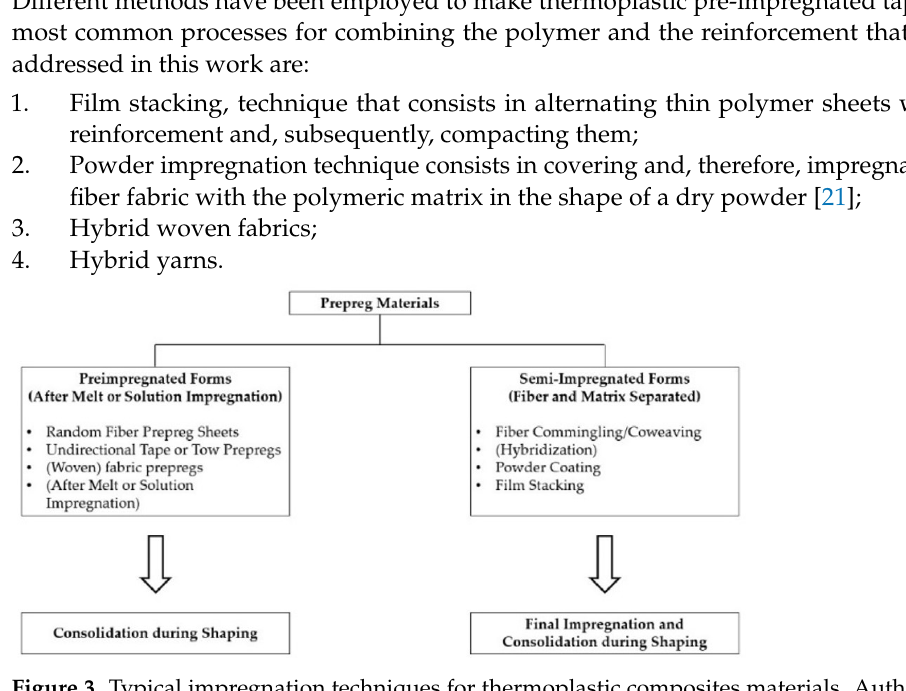
Figure 4. Schematic of film stacking process for thermoplastic composite laminates. Author’s own figure. Temperature, pressure, and holding time are the core parameters to control the pro- cess. Their values depend on the nature of the polymer, mainly melting temperature and viscosity, as well as on the fabric tortuosity and the load and temperature the fibers can sustain [23]. Below a comprehensive literature survey on the influence of these process parameters on the properties of film-stacked thermoplastic composites is reported. 2.1.1. Influence Mechanism of Processing Temperature Processing temperature considerably affects the mechanical and microstructural properties of the composite produced. It is known that the use of thermoplastic resins introduces the issue of adequate fiber bed impregnation because of the higher viscosity of thermoplastic melts than thermosetting ones. Optimization in processing temperature is crucial. High temperature pressing scheme promote a lower resin’s viscosity and there- fore greater mobility and fluidity to penetrate between the fibers and impregnate them. On the other hand, the use of high temperatures potentially clashes with the thermal sta- bility of the materials constituting the composite. Then, an optimal condition will exist